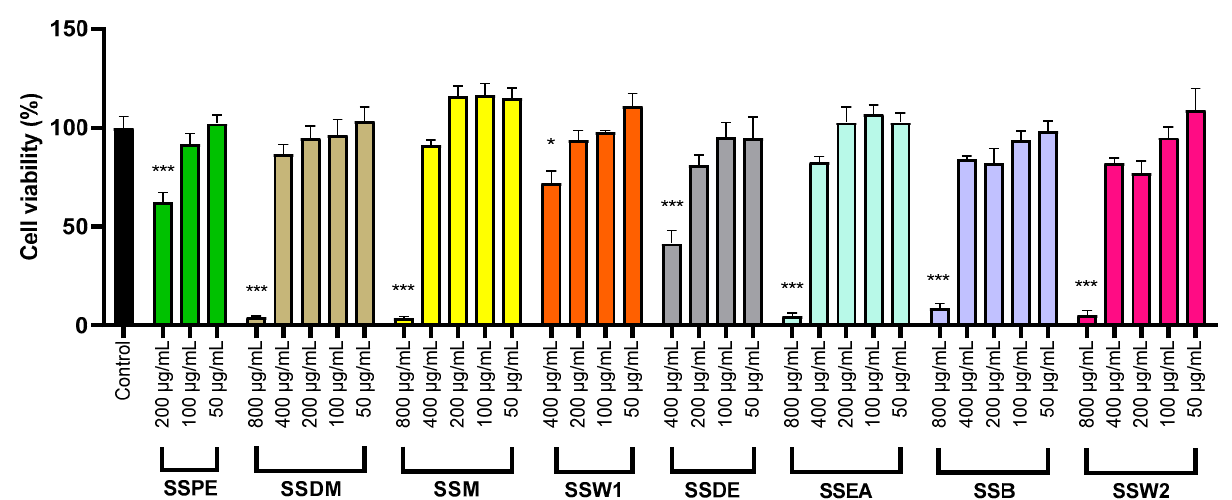
Figure 3. Determination of the maximum non-toxic concentrations of the different SS mixtures on SH-SY5Y cells. The error bars display the SEM from five separate tests. Note: * shows statistical signi fi cance of p < 0.05 and *** of p < 0.001 when compared to control untreated cells. Table 4. Cytotoxic potency of SS extracts in SH-SY5Y cells in terms of half-maximal e ff ective concentrations. EC 50 corresponds to the concentration of extract required to reduce the cell viability by 50%.